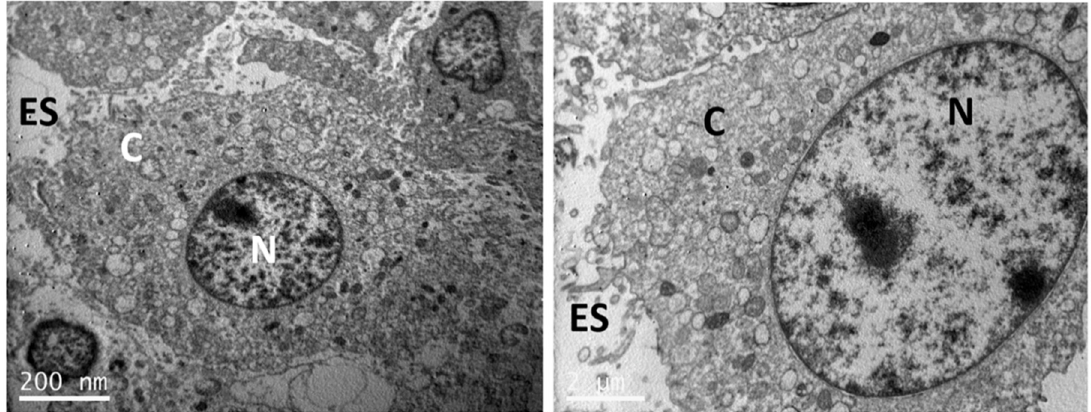
Figure 8. Representative TEM images showing pre-osteoblastic cells (control) in the absence of any nHA samples. The scale bar represents 200 nm (left) and 2 μ m (right). The letter N designates the nucleus, C the cytoplasm and ES the extracellular space.